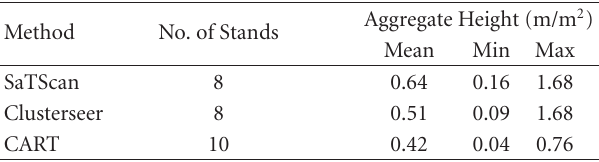
Table 1: Mean and range of aggregate height of stands predicted as regeneration hotspots by di ff erent